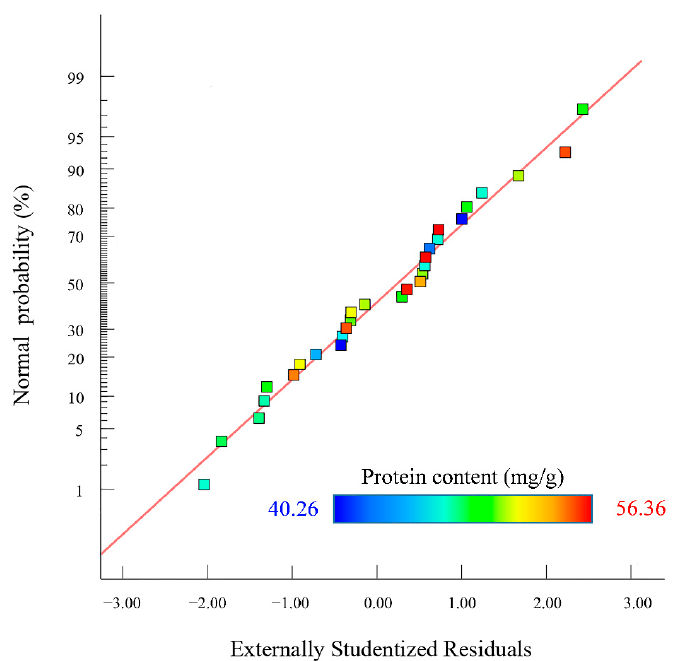
Figure 3. Normal probability distribution of residuals.